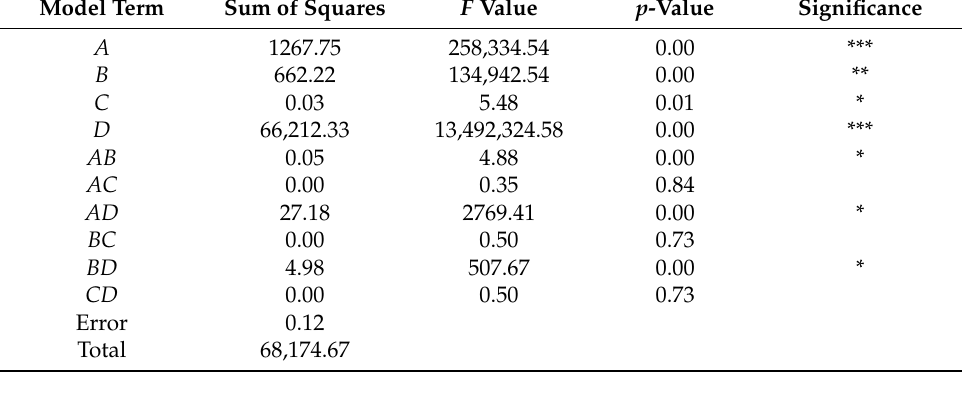
Table 6. Results of ANOVA for the post-flood period runoff simulation.